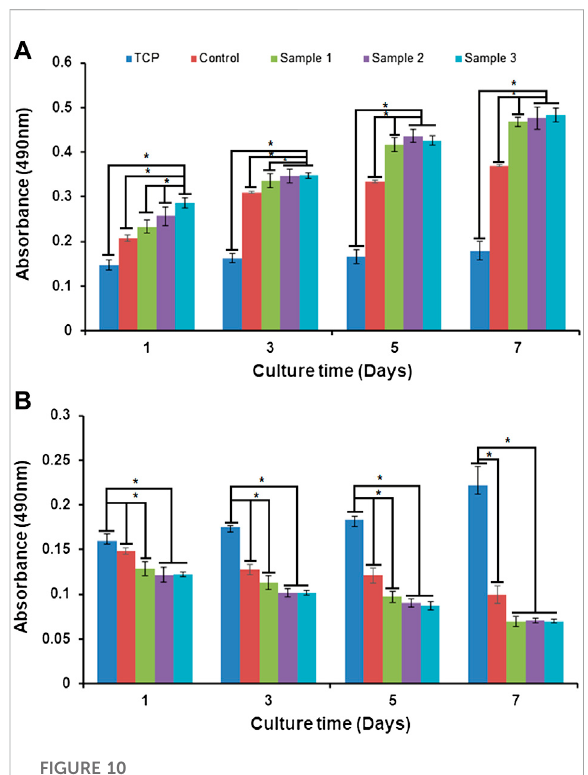
FIGURE 10 In vitro cell biocompatibility via MTT assay of (A) fi broblast cellsand (B) carcinomacellsculturedintissuecultureplates(TCP), and with control beads or ESMP-modi fi ed sample beads. Here, * indicates the signi fi cant difference between samples ( p <